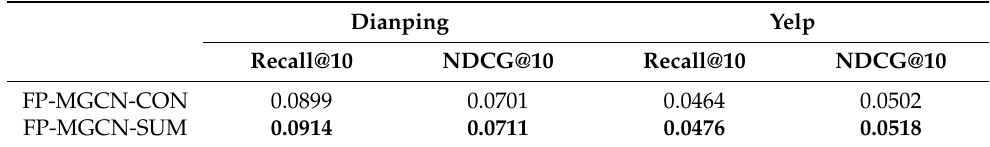
Table 4. The impact of different aggregators on the model.